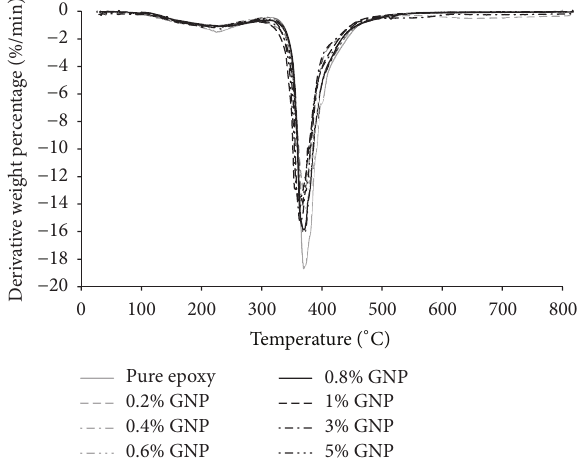
Figure 9: DTG curves for GNP filled epoxy composites.